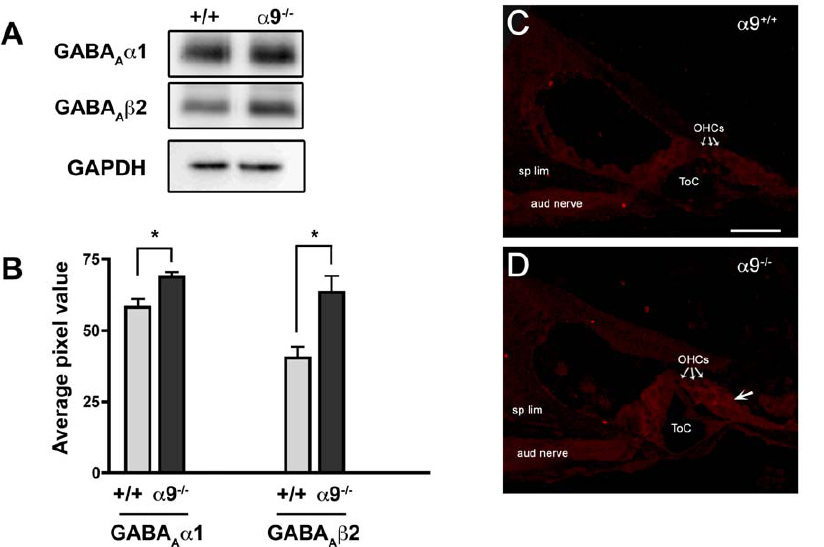
Figure 4. Quantitative protein expression analysis of select GABA receptor subunits and cellular localization of changes to GABA A b 2 expression. ( A ) Protein expression of GABA A subunits was assessed by immunoprecipitation (IP) to confirm changes observed at a transcriptional level. 200 m g cochlear lysates from wild type and a 9 2 / 2 were subjected to IP with antibodies against GABA A a 1 and GABA A b 2 subunits. The immunoprecipitates were analysed by western blotting with anti-GABA A a 1 or anti- GABA A b 2. A separate western blot was run in parallel using the same lysates used for IP experiments for wild type and a 9 2 / 2 samples. A representative western blot including GAPDH loading control is shown. ( B ) Quantitative western blot analyses for GABA A a 1 and GABA A b 2 are shown. Average pixel values averaged over biological triplicates from IP experiments are indicated for wild type and a 9 2 / 2 . GABA A a 1 protein expression increased by 18% in a 9 2 / 2 ( p =0.041) and GABA A b 2 expression increased by 58% in a 9 2 / 2 ( p =0.029) when compared to wild type. Error bars indicate SEM, and a significant change is denoted with an asterisk (two- tailed t -test). ( C ) In adult wild type ears, GABA A b 2 immunostaining is observed in the inner and outer hair cells. ( D ) In a 9 2 / 2 OHCs, GABA A b 2 immunolabeling is particularly dense in the apical regions, as well as at the synaptic pole. The small arrows indicate outer hair cells and the larger arrow in (D) indicates the border between outer hair cells and Deiters’ cells. Sp lim , spiral limbus; ToC , tunnel of Corti; OHC , outer hair cell. Scale bar, 25 m m.